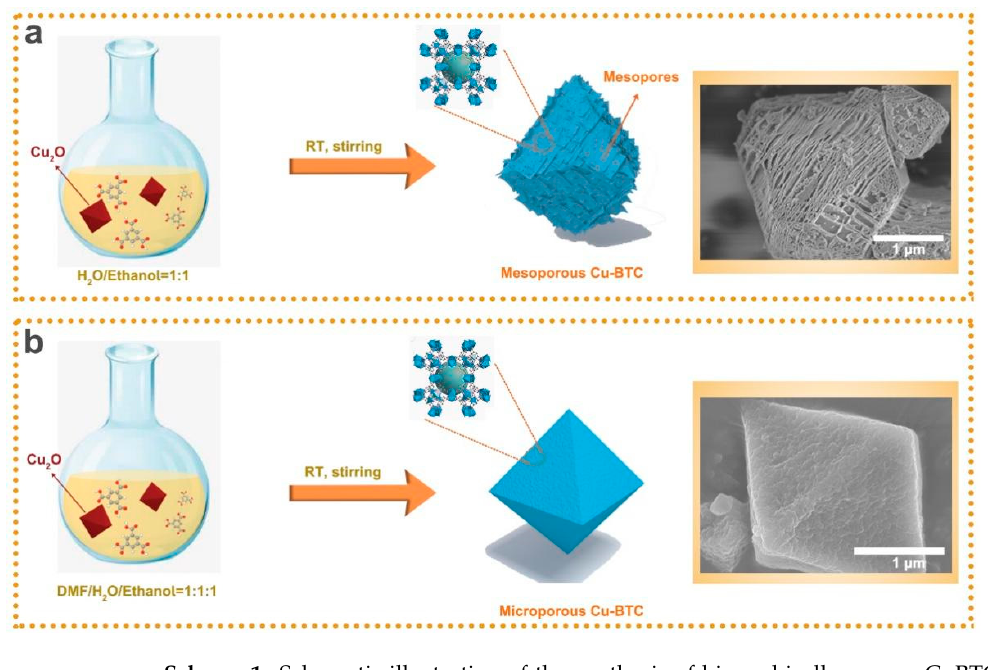
Scheme 1. Schematic illustration of the synthesis of hierarchically porous CuBTC-Water ( a ) and microporous CuBTC-DMF ( b ).